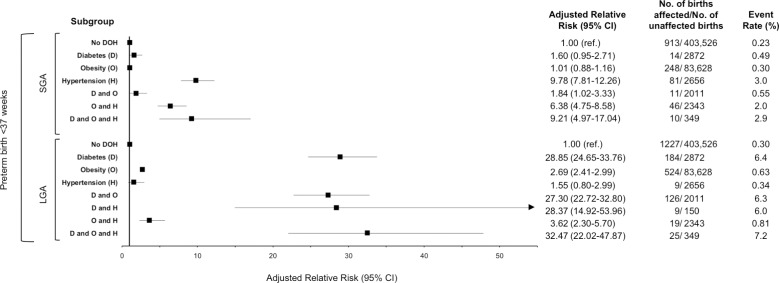
Adjusted relative risks of pre-existing diabetes, obesity and hypertension on preterm birth with small for gestational age or large for gestational age at <37 weeks in women with a singleton birth in Ontario, between April 1, 2012 to March 31, 2016.* Data for SGA in the combined D and H group was suppressed by BORN Ontario due to event rate below reporting threshold.